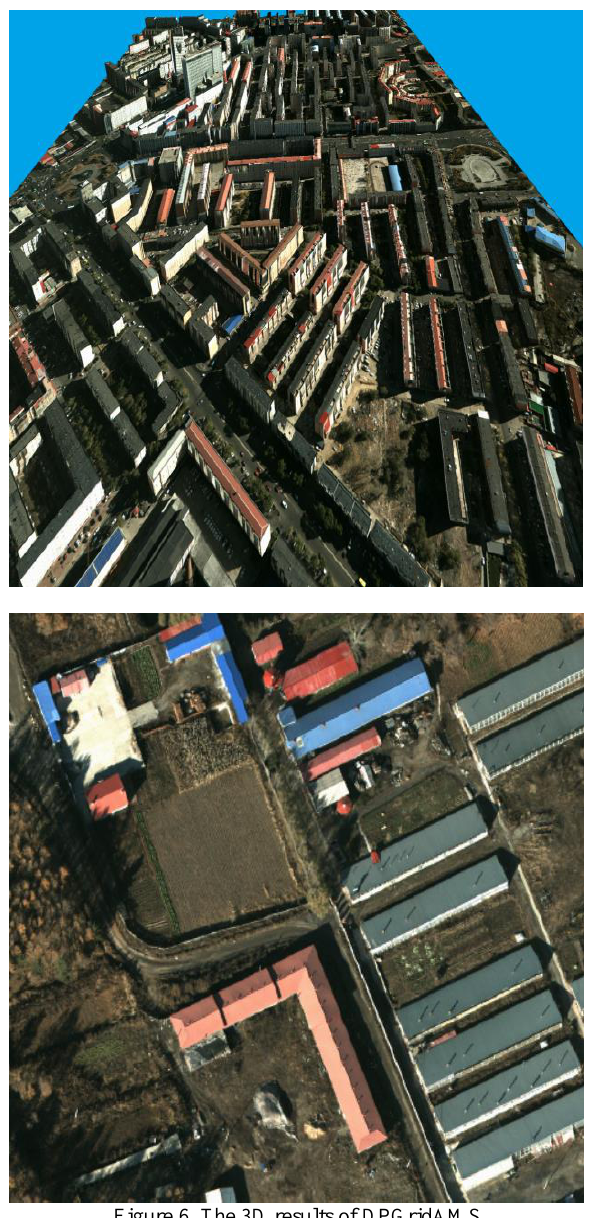
Figure 6. The 3D results of